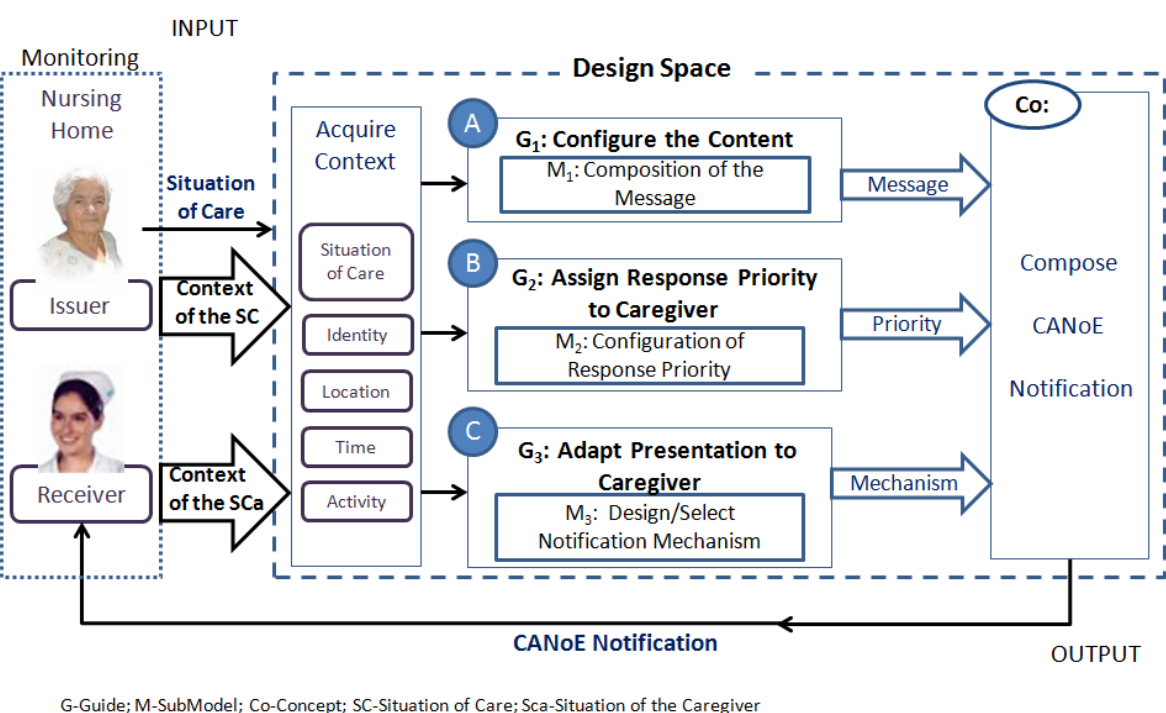
Figure 1. Schematic view of the CANoE (Context-Aware Notification for critical Environments) model for a nursing